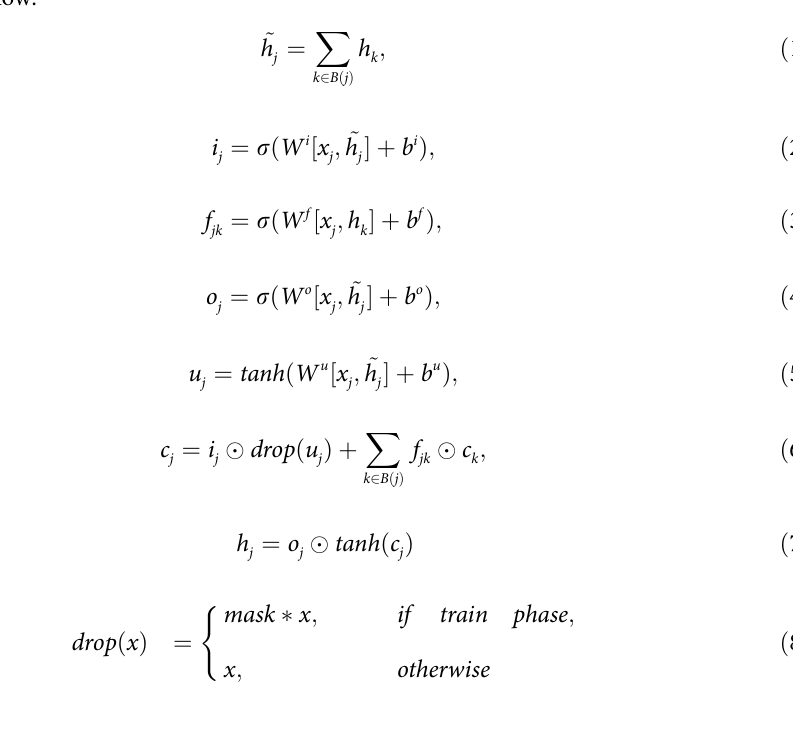
gate, output gate, memory cell, and the hidden state, respectively. u is a temporary value that could be added to the memory cell state. drop ( x ) in Eq (8) is a recurrent dropout [29] function. The mask is a sampled vector from the random distribution with probability keep _ p that is used to decide which element is kept or dropped. The binary tree-LSTM equations are described below.